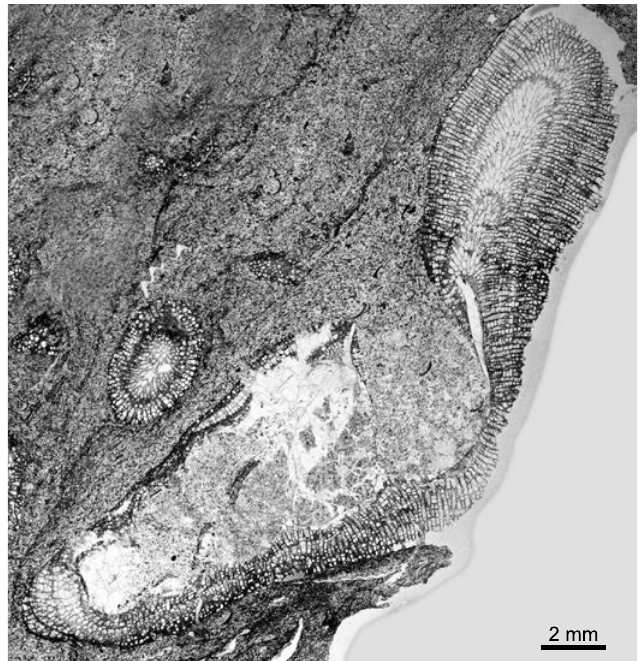
Fig. 4. Thin section of trepostome bryozoan Homotrypa cochlea sp. nov. from Upper Leintwardine Formation, Ludfordian, upper Ludlow; Delbury Quarry, Shropshire, UK. Holotype, NMW 2019.21G.2.3, bryozoan colony encrusting gastropod shell and developing ramose form at shell